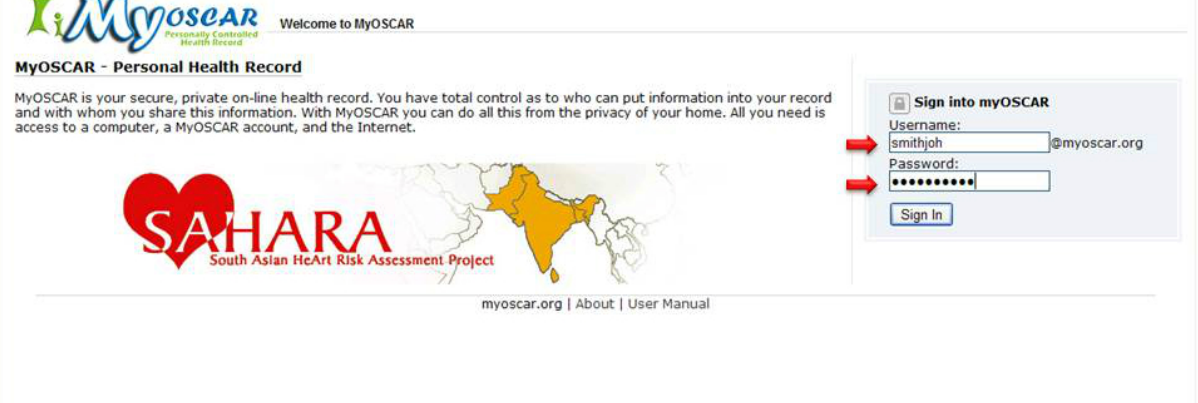
Figure 6. MyOSCAR Web